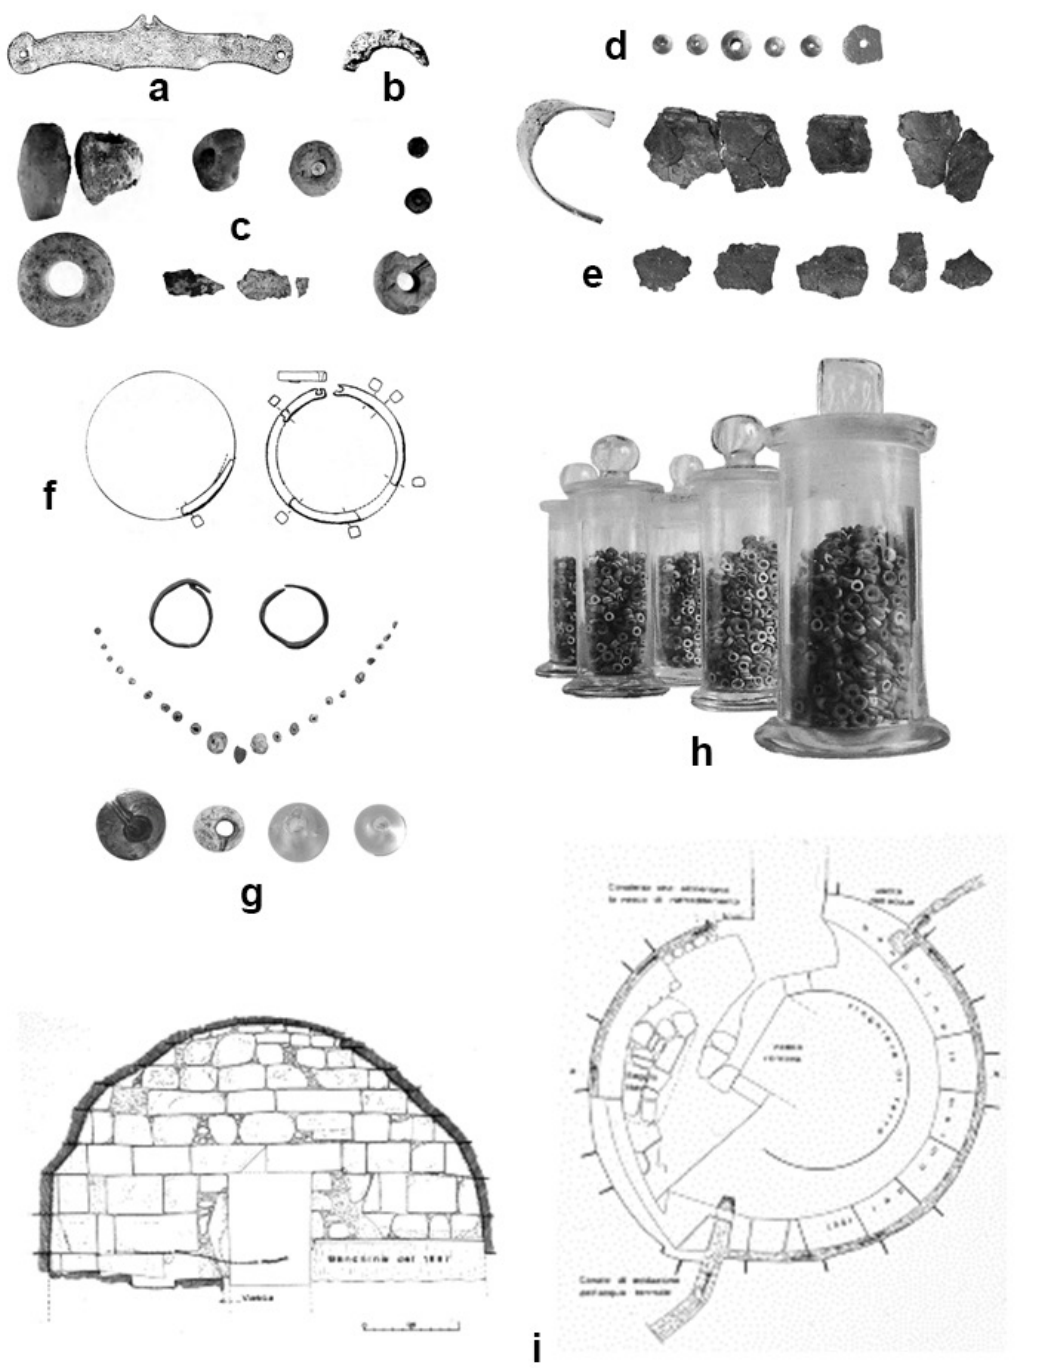
Figure 2: a) Metal scale from tomb 22 of Castelluccio (Crispino & Cultraro, 2015); b) Iron ring from tomb 23 of Castelluccio (Orsi, 1893); c) Stone weight set and elements of metal scale from tomb 22 of Castelluccio (Crispino & Cultraro, 2015); d) Glass and amber beads from Grotta Maccarrone di Adrano (Cultraro, 2007); e) Late Helladic I–II type bronze cup from Grotta Maccarrone di Adrano (Cultraro, 2007); f) Ivory bracelets from Mursia (Ardesia et al., 2012); g) Bronze earrings, neckclace of glass beads, glass beads coated in gold and silver sheet and rock crystal beads (after Marazzi, 2016); h) Glass beads from Tarxien Cemetery (Trump, 2002); i) Stufa Termale di San Calogero (tholos) at Lipari (Bernabò Brea et al.,